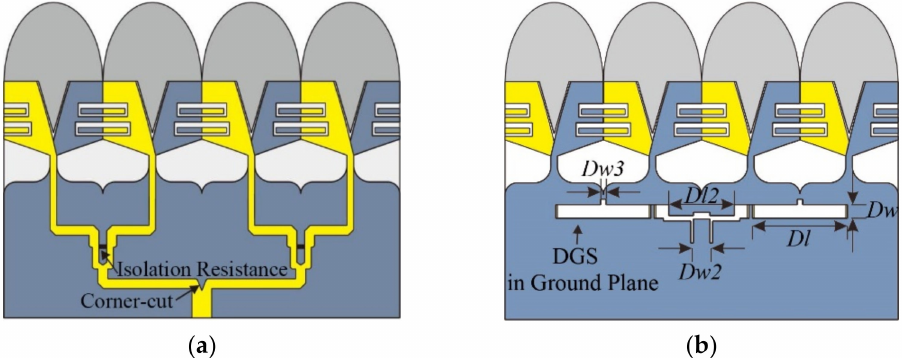
Figure 13. Configurations of the proposed antenna array fed by 1–4 Wilkinson power divider with two isolation resistances, ( a ) front of view and ( b ) back of view, of the DGS designed on the